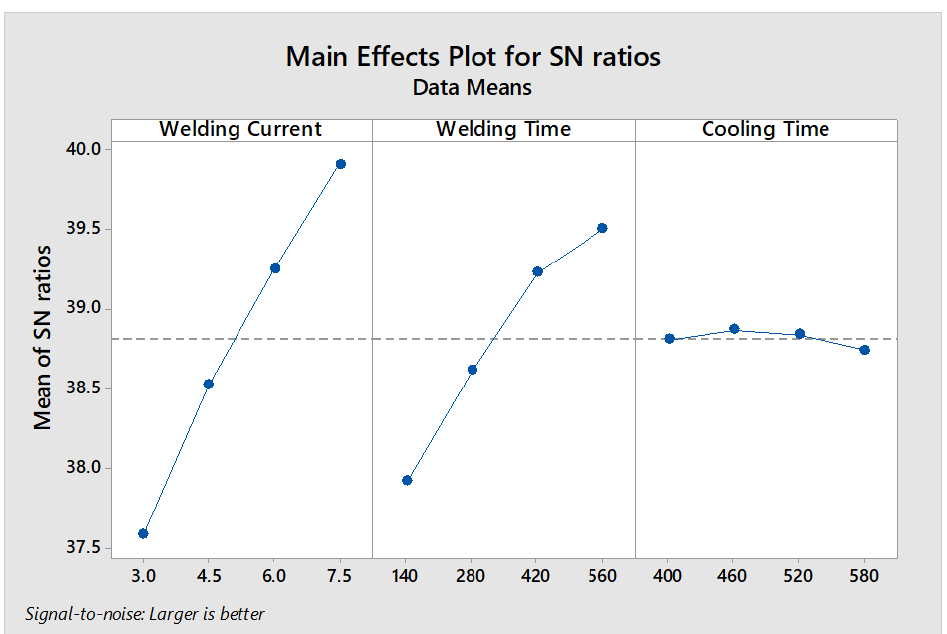
Figure 7. Graph representing main effects for failure energy.